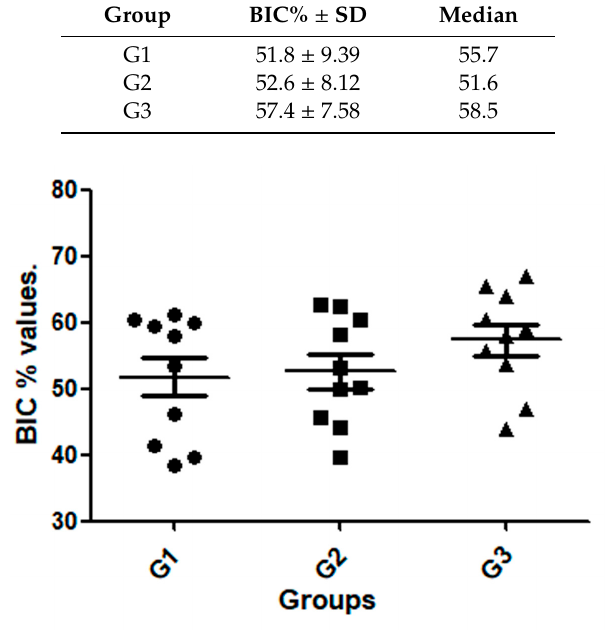
Table 2. Table data (mean, standard deviation, and median) and graph values distribution of the bone-to-implant contact percentage (BIC%) measured around of the surface of each sample.